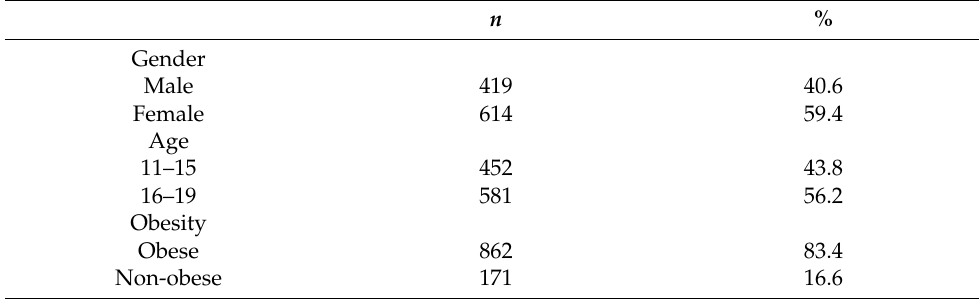
Table 1. Basic information of the